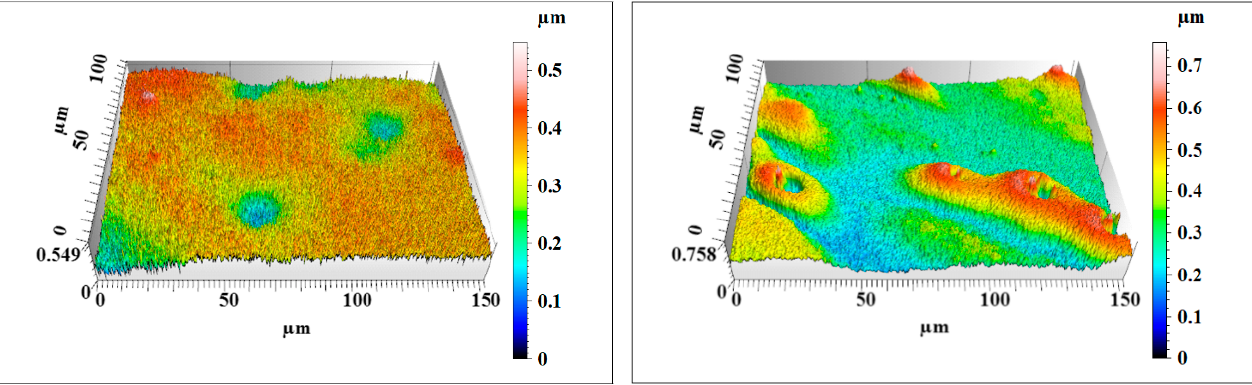
Figure 14. The original Si workpiece surface morphology.